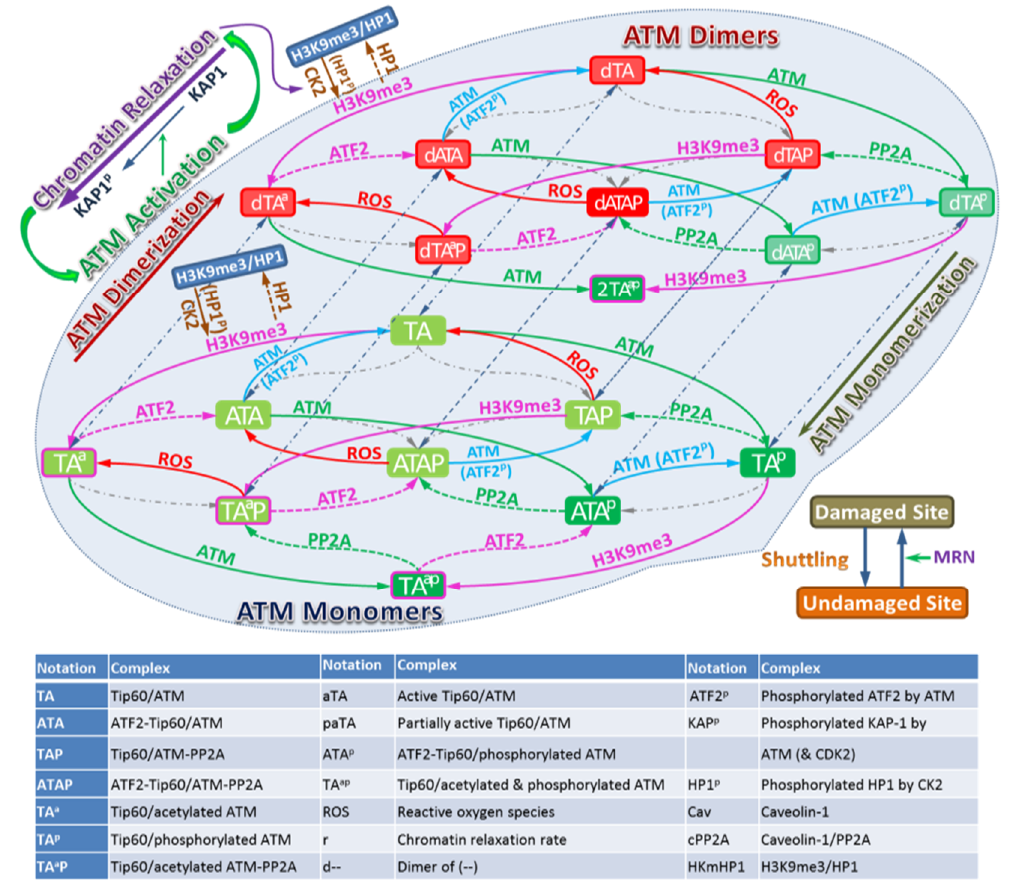
Figure 2. Schematic description of the model for ATM Activation. The left panel considers undamaged chromatin and the middle panel damaged chromatin. Biochemical species included in the model are indicating by the Legend in Figure 2 with arrows illustrating interactions included in the model.